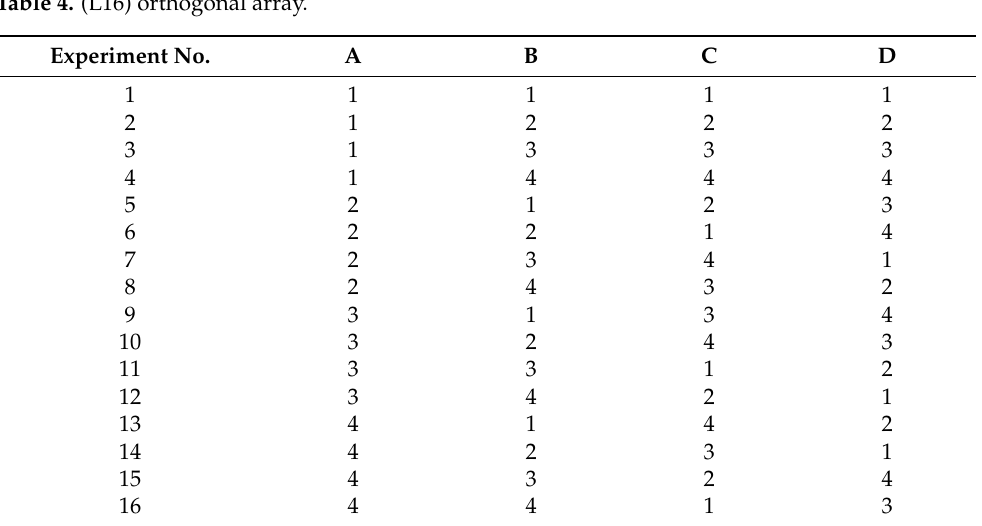
Table 4. (L16) orthogonal array. Experiment